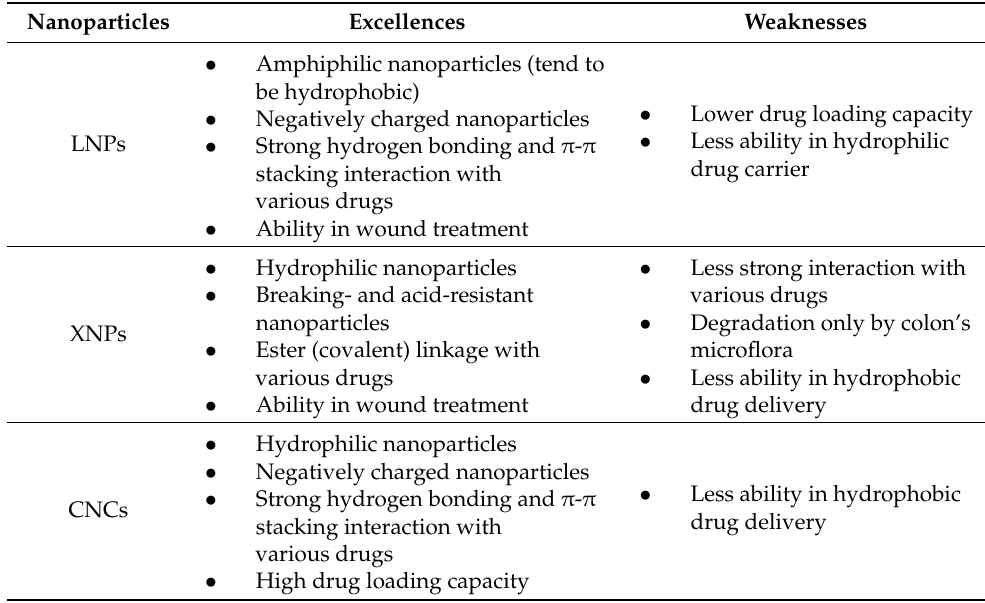
Table 6. The excellences and weaknesses of LNPs, XNPs, and CNCs for drug delivery application.